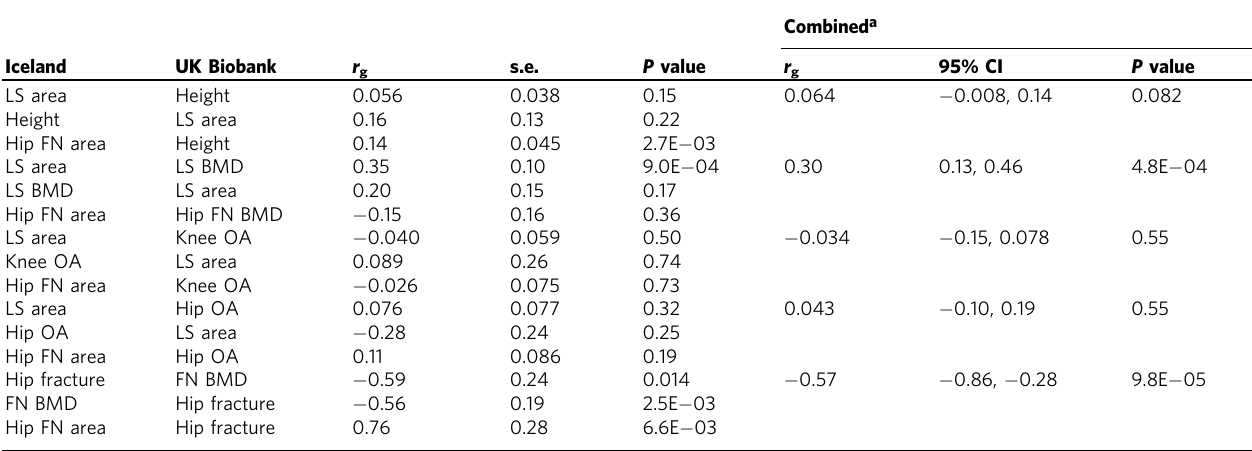
Table 4 Estimated genetic correlation